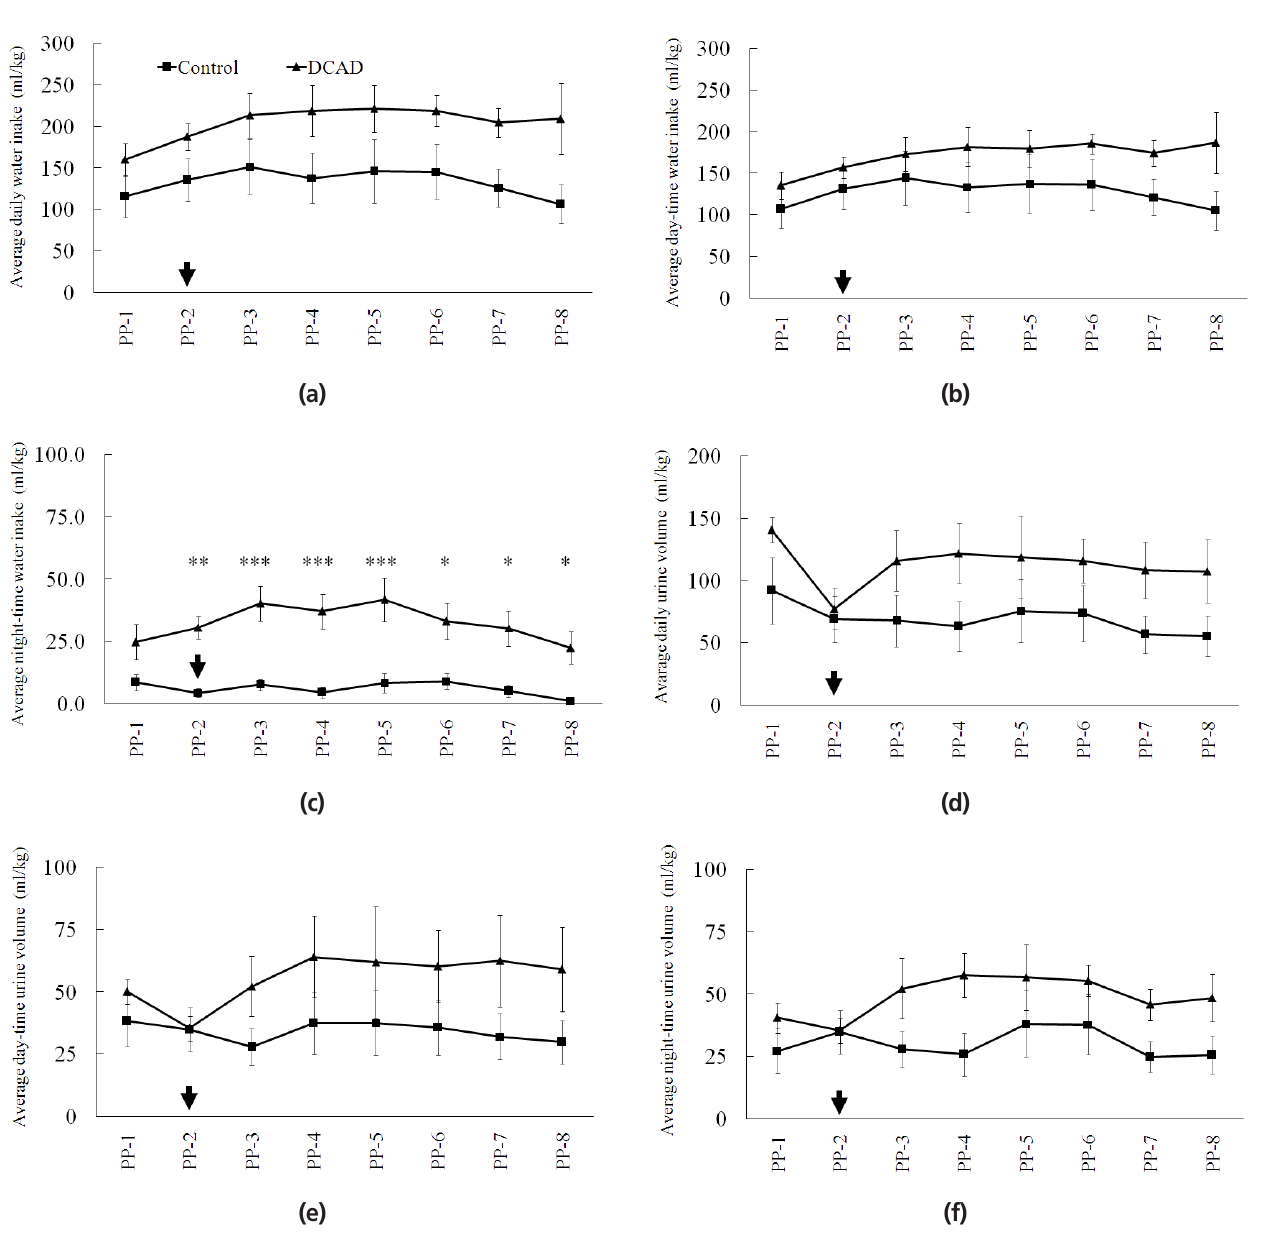
Figure 2. Effect of high dietary cation and anion difference on total water intake (WI) and urine volume (UV). Control or dietary cation anion different (DCAD) rations were provided from the 2nd week postpartum (PP-2, arrow) and DCAD effect was observed until the 8th postpartum (PP-8). High DCAD had no effects on the average daily WI (a) and day-time WI (b). However, the night-time WI (c) from DCAD group was higher than from the control group. There were no effects of DCAD on the average daily UV (d), day-time UV (e), and night-time UV (f). Asterisks at the specific time point indicate a significant difference within the day time. * p<0.05; ** p<0.01; ***